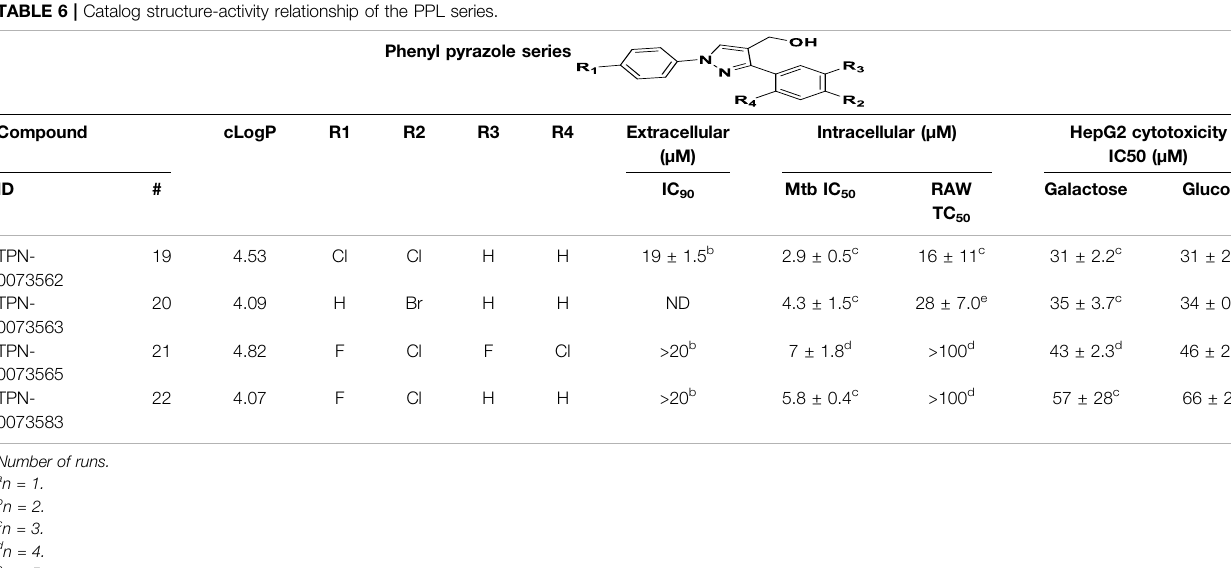
TABLE 6 | Catalog structure-activity relationship of the PPL